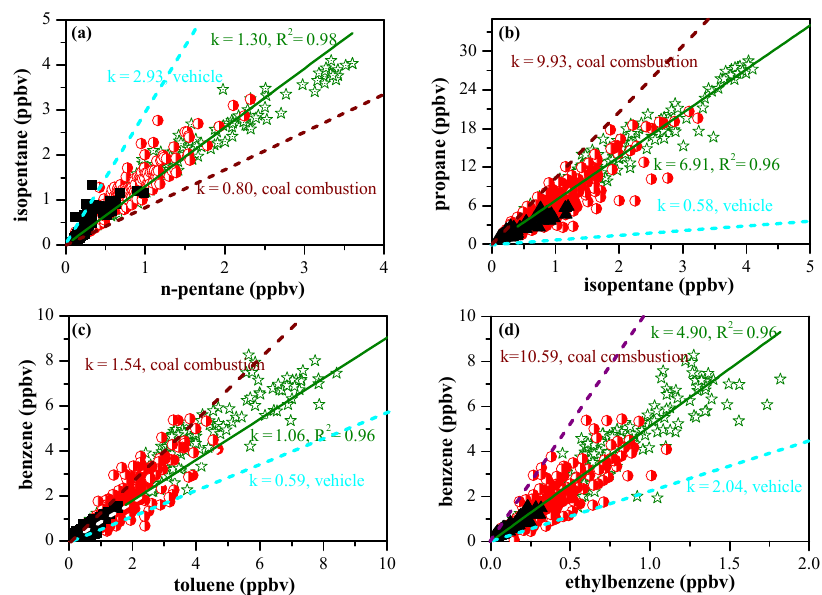
Figure 5. Ratios and linear correlation coefficients ( R 2 ) between (a) isopentane and n-pentane, (b) propane and isopentane, (c) benzene and toluene, and (d) benzene and ethylbenzene during clear days (in black), light haze days (in red), and heavy haze days (in